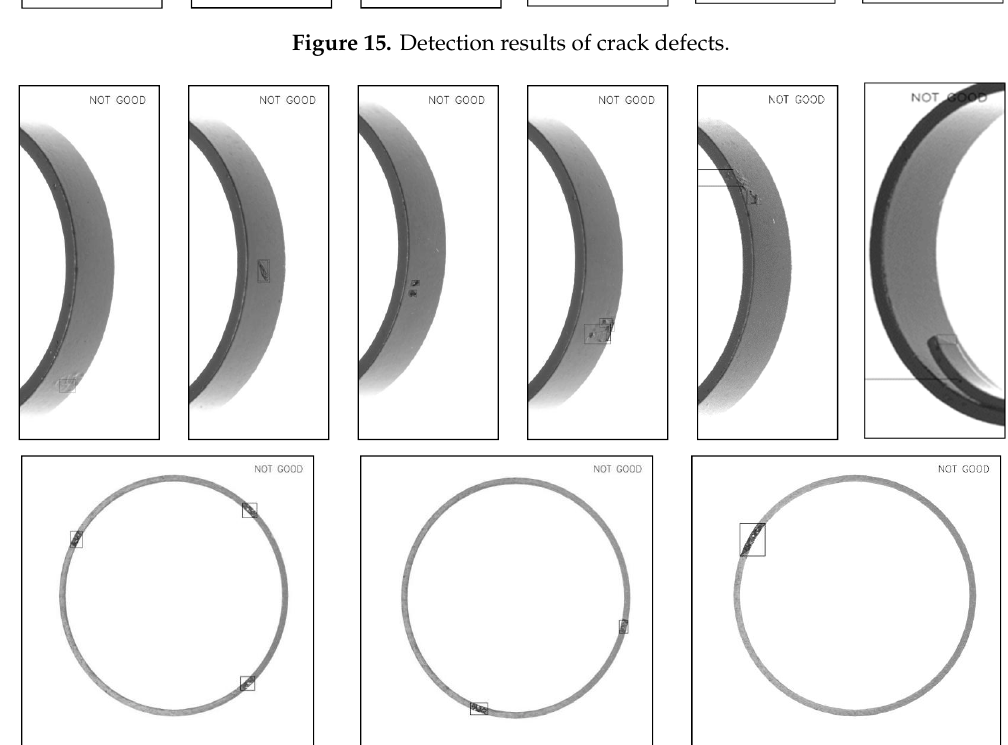
Figure 16. Detection results of large-area defects.